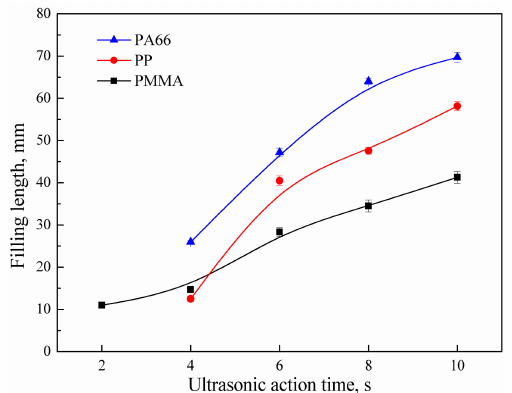
Figure 3. Influence of ultrasonic action time on the filling length of polymer melt (UA = 40 µ m, PPe = 14 MPa, HT = 6 s, HP = 14 MPa, MT = 60 °C; Mold I).